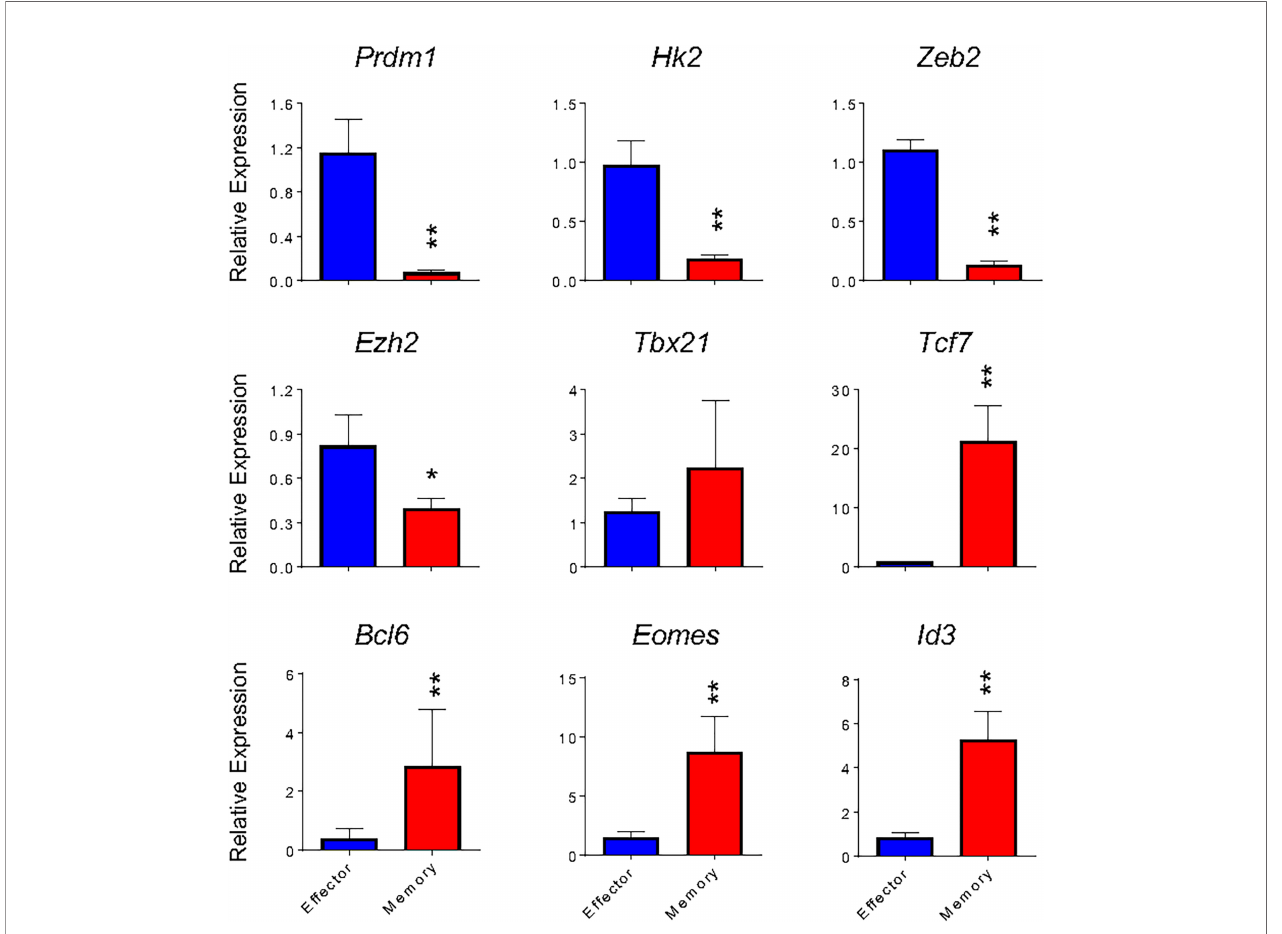
FIGURE 4 | Gene expression of in vitro effector and memory CD8 T cells cultures. Total RNA was extracted from effector (blue) and memory (red) T cells differentiated in vitro at the 5 th and 10 th days, respectively, and analyzed by real-time RT-PCR using the TaqMan probe for indicated genes. The data were normalized to the Hprt housekeeping gene. Bar graphs represent the mean ( ± SD) of RNA expression analysis. The (*) indicates p < 0.05 and (**) p < 0.01 compared with the lowest Ct mean obtained from the effector differentiation. All results are representative at least of 4 independent